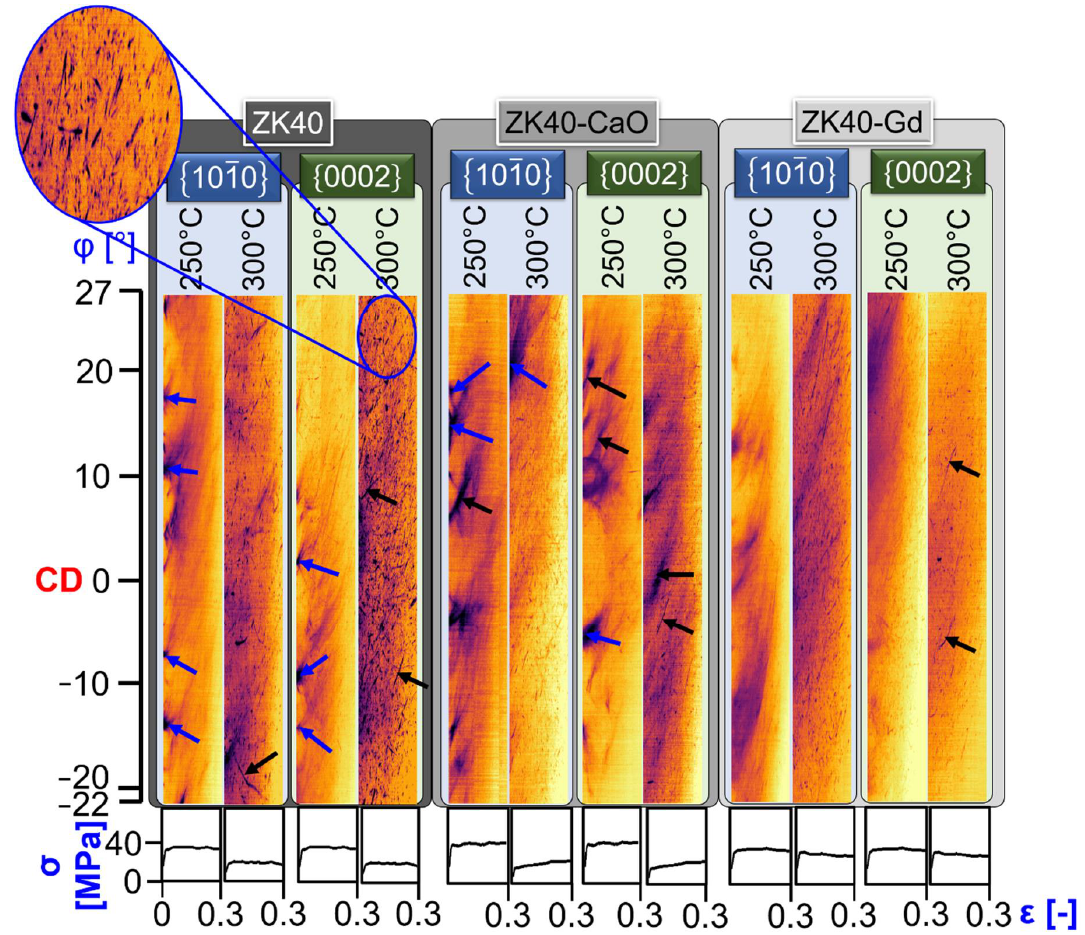
Figure 8. Azimuthal-strain plots for the three investigated alloys tested at 250 °C and 300 °C for the strain rate of 0.0001 s −1 . Blue arrows indicate the intense spread of orientation in the diffraction rings and the decay in the intensity of the diffraction signal. Black arrows indicate the bending of the timelines. CD indicates the compression direction. The azimuthal-time plots of the of the {101(cid:3364)0} and {0002} are shown in Figure 9 for the deformed samples at 0.001 s −1 . Similar to the azimuthal-strain plots obtained for the 0.0001 s −1 (Figure 8), the deformation of the investigated alloys at 0.001 s −1 leads to the formation of: